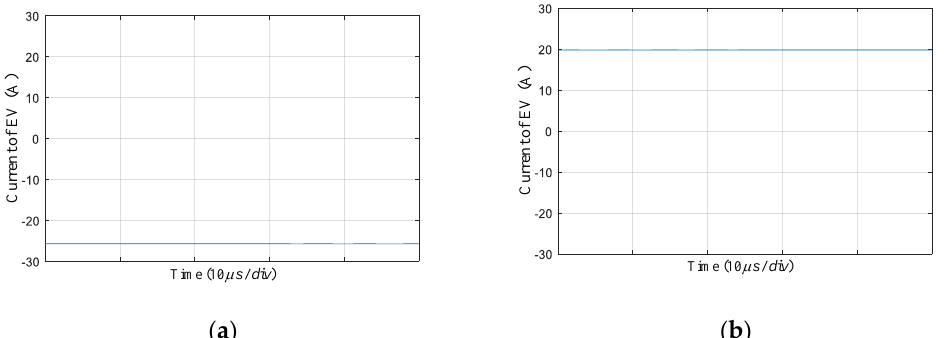
Figure 13. Current of EV in ( a ) the forward direction and ( b ) the reverse direction.